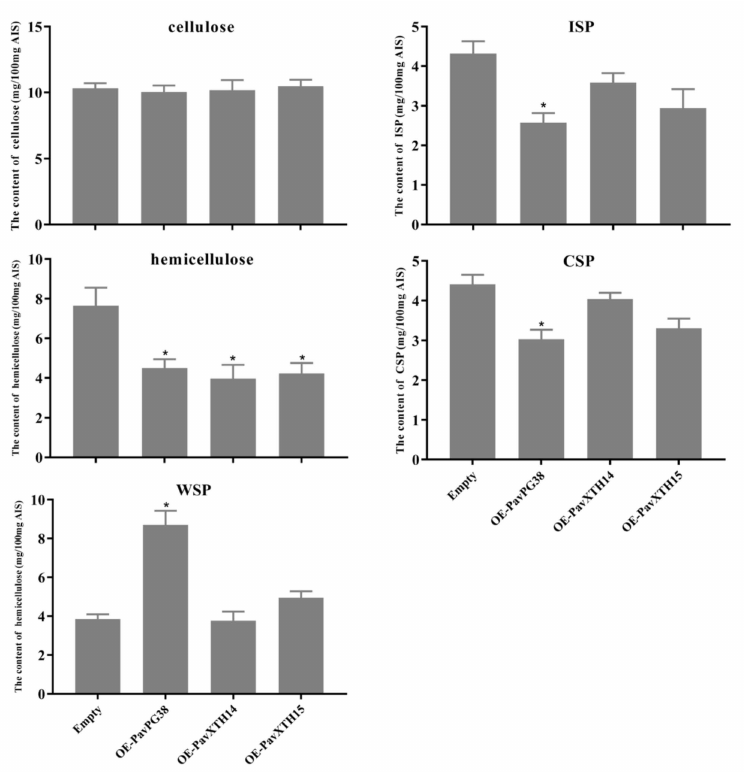
Figure 8. The content of cell wall compositions in transgenic fruit. CSP, WSP, ISP and AIS refer to the covalent pectin, water-soluble pectin, ion-linked pectin, and alcohol insoluble substance. The empty vector was used as a control. Values are the means ± SD from three biological replicates. Significant differences in values (* p < 0.05) were determined by Student’s t